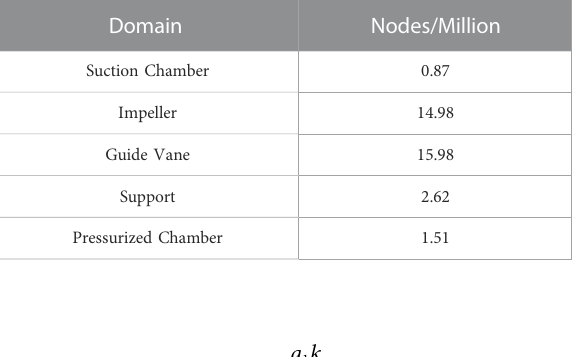
TABLE 1 Mesh details for each